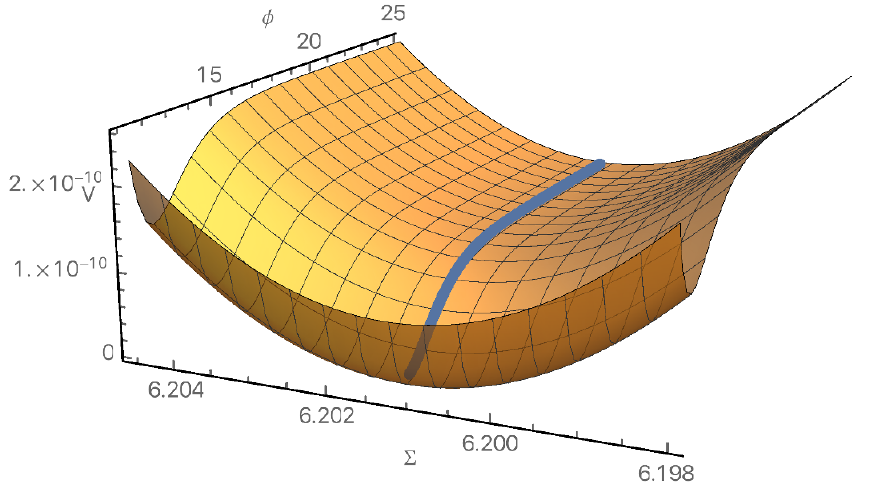
Figure 1 . In(cid:13)ationary potential in terms of the canonically normalised (cid:12)elds (cid:6) and (cid:30) . We have chosen D = 10, leading to n = p = 5, as well as f = 100 and (cid:11) = 312 : 496. With these values one (cid:12)nds (cid:3) = 1 in four-dimensional Planck units. The blue line indicates a possible slow-roll trajectory starting on the plateau. Notice the di(cid:11)erent scales on the (cid:30) and (cid:6) axes, indicating the large mass